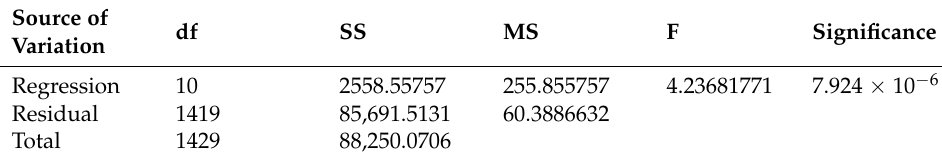
Table 5. ANOVA for regression analysis.